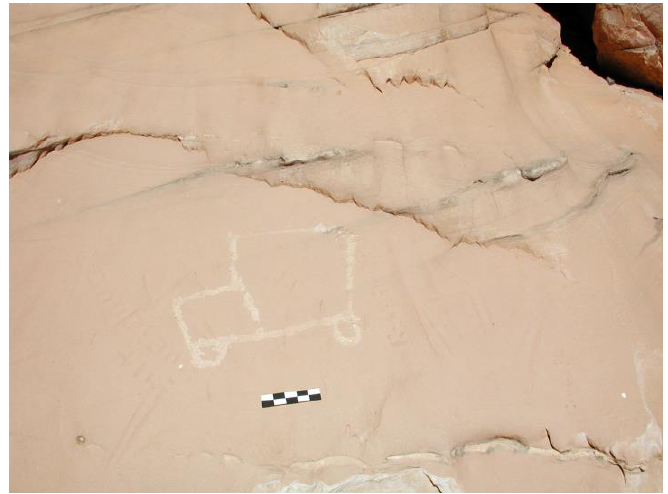
Figure 8. Modern Camel Style: four-wheel drive car, engraved on a rockshelter in Wadi Rahrmellen.